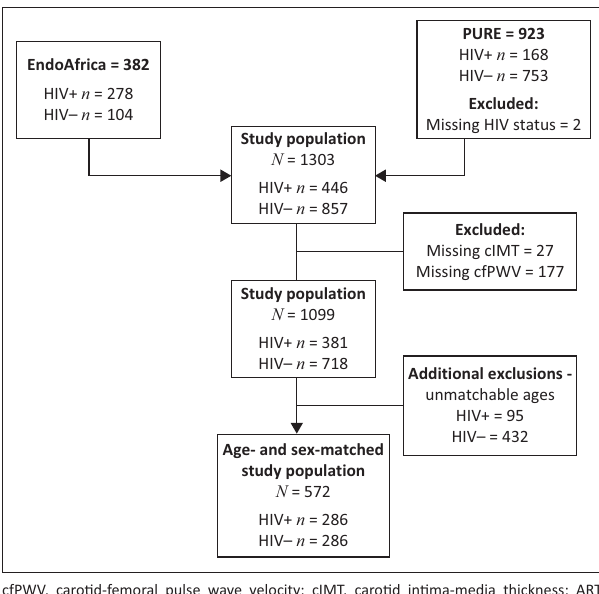
FIGURE 1: Study population of the EndoAfrica and the PURE